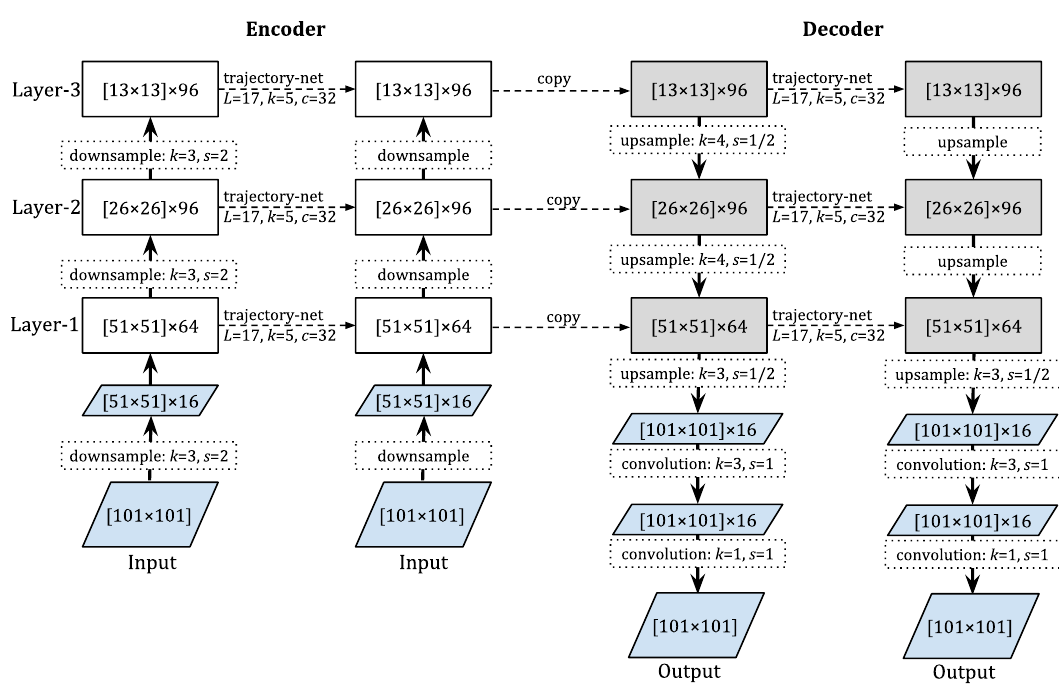
Figure 4. The three-layer TrajGRU model for one-channel image sequence (two input steps and two output steps). The cells are presented in rectangles with state [ a × a ] × b ( [ a × a ] is the size of image, feature map, or cell states, and b is the number of feature maps or state maps). One down-sampling is a convolution, and one up-sampling is a deconvolution. In each layer, the step-to-step transition is done by a “trajectory-net” (Figure 2), which produces flow fields used for a warping process to calculate the current state. In this figure, L is the number of tracked points, while k is the kernel size and c is the number of filters of the convolutional operations. ConvGRU or ConvLSTM models can be implemented by simply replacing these trajectory-net blocks with the common convolution with the stride size s = 1. In this study, we used kernel size k = 5 for all of the step-to-step